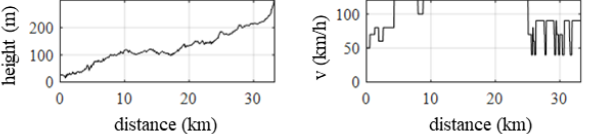
Figure 3. Altitude above sea level and speed limits along the route.